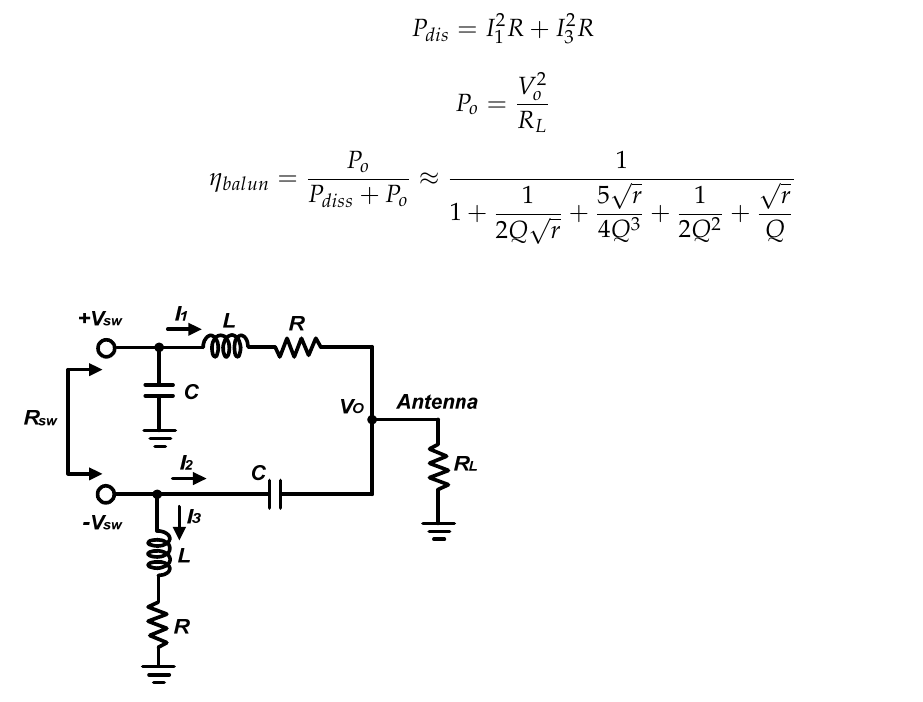
Figure 12. The schematic of an LC balun. Based on this equation, efficiencies of the LC balun with different transformation ratio have been plotted in Figures 13 and 14 considering practical inductor Q-factors.